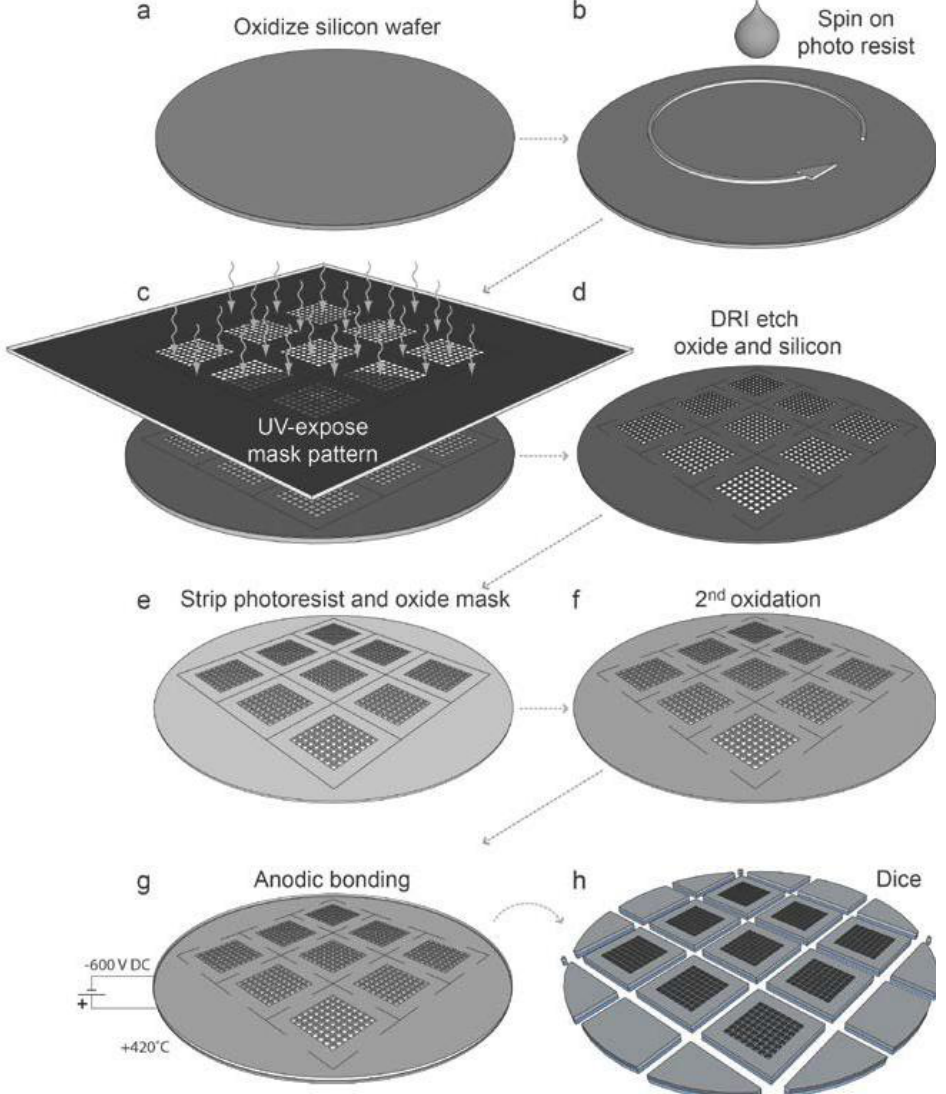
Figure 1. Schematic outline of the silicon-glass microplate fabrication process. ( a ) Oxidized silicon wafer, 100 mm in diameter, 300 µm thick; ( b ) Spin coating of wafer with positive photoresist; ( c ) Masked UV-exposure of photoresist layer; ( d ) Plasma etching of the oxidized silicon wafer; ( e ) Removal of photoresist and oxide mask; ( f ) Oxidation of the wafer after the strip of the photoresist and oxide mask; ( g ) The anodic bonding of the 175 µm thick glass bottom to the silicon “grid”; ( h ) Dicing to individual chips, 9 per wafer, where each final chip is 22 × 22 mm 2 . Based on a figure in Ref.